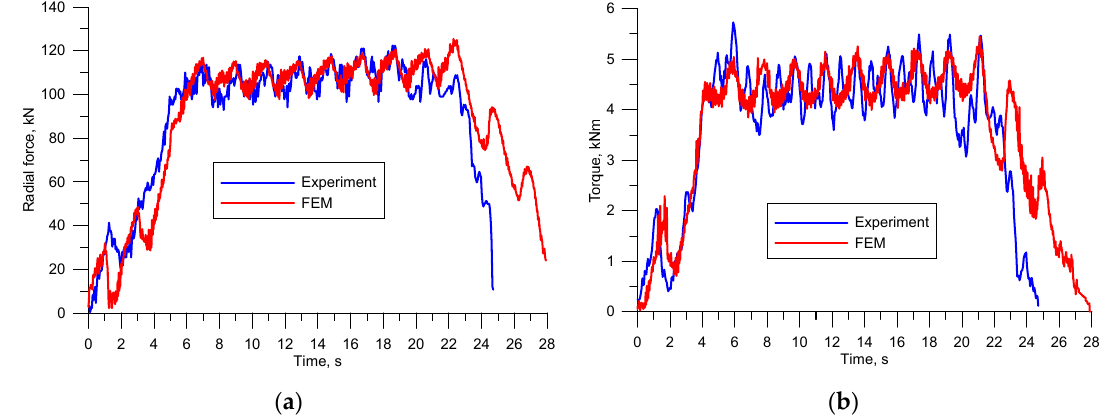
Figure 19. Distribution of force parameters during rolling of rods in the skew rolling mill: ( a ) radial force; ( b ) torque.